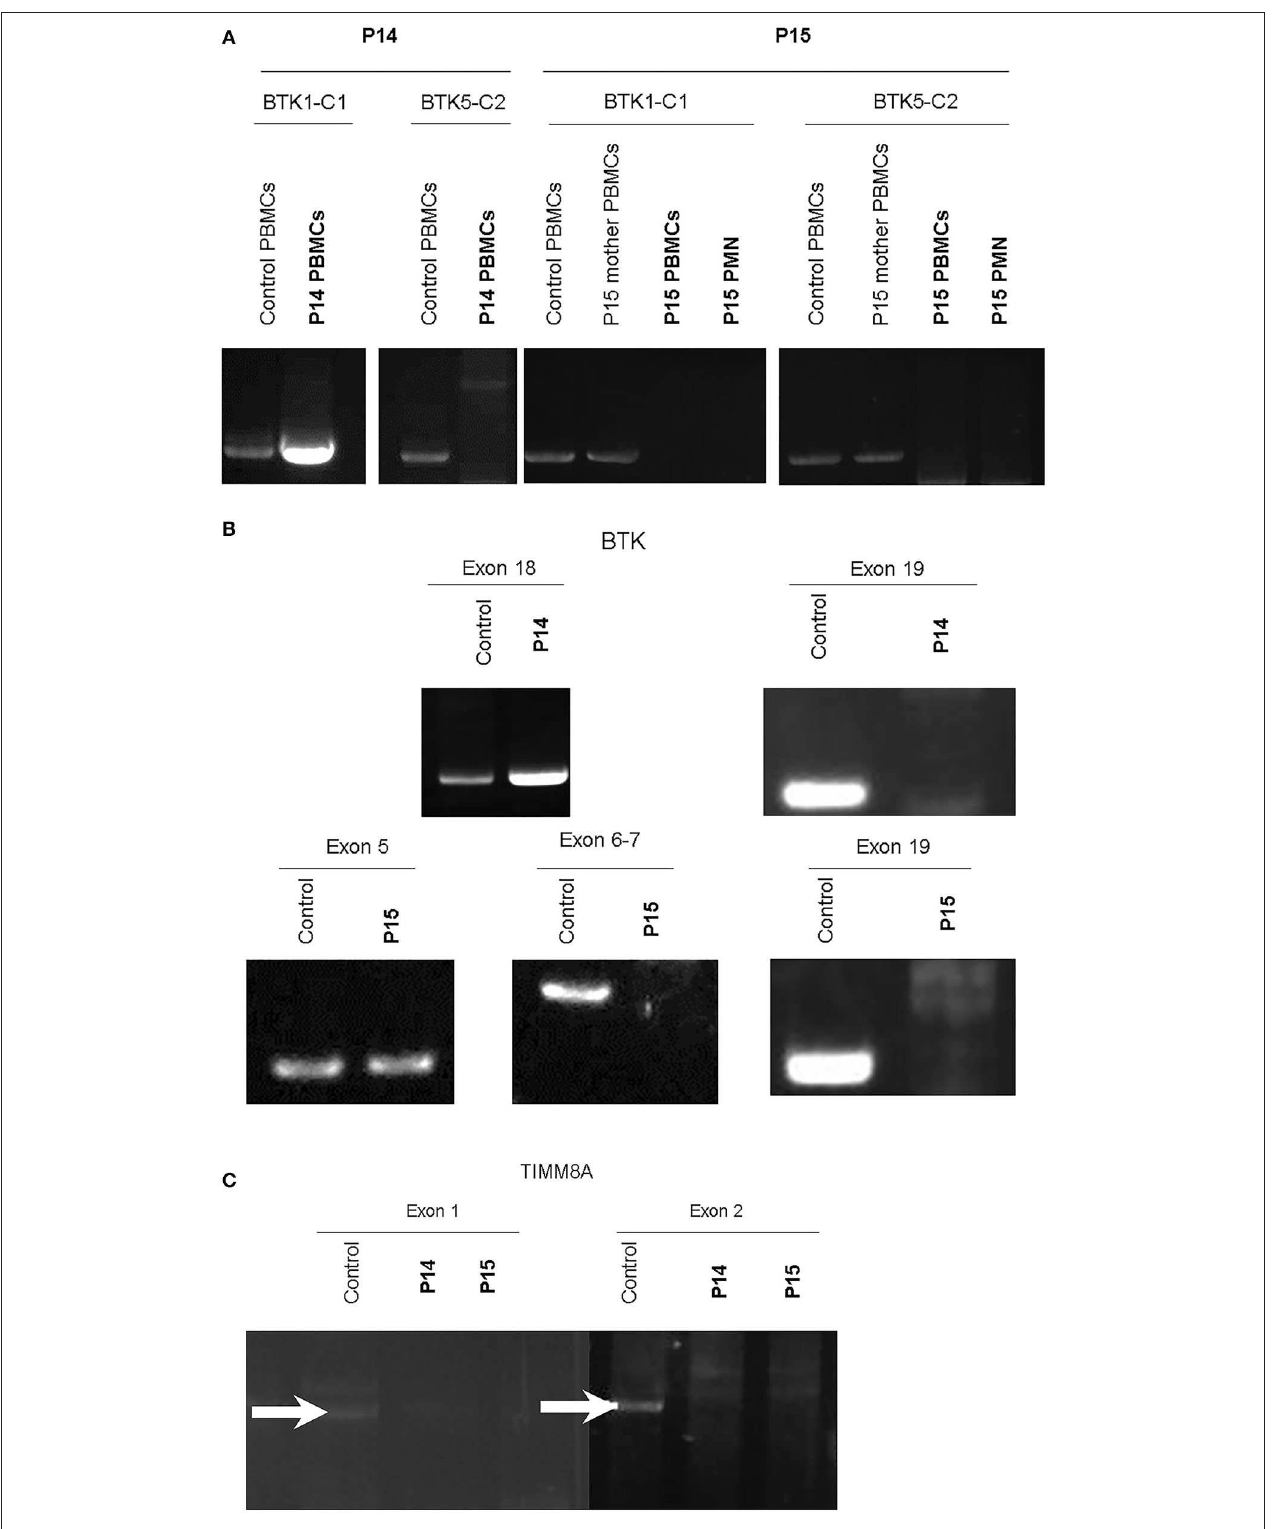
FIGURE 2 | RT-PCR amplification of cDNA included two designed two pairs: BTK1-BTKC1 for the coding region from exon 1 to exon 13 (product 1,277 b.p.); and BTC5-BTKC2 (1,253 b.p.) for the coding region from exon 11 to exon 19. Compared to the healthy control and mother of P15, only cDNA amplification by RT-PCR of the product from BTK1-BTKC1 was right detectable in P14, and the others were all undetectable. PMNs should express BTK , but much lower than PBMCs.